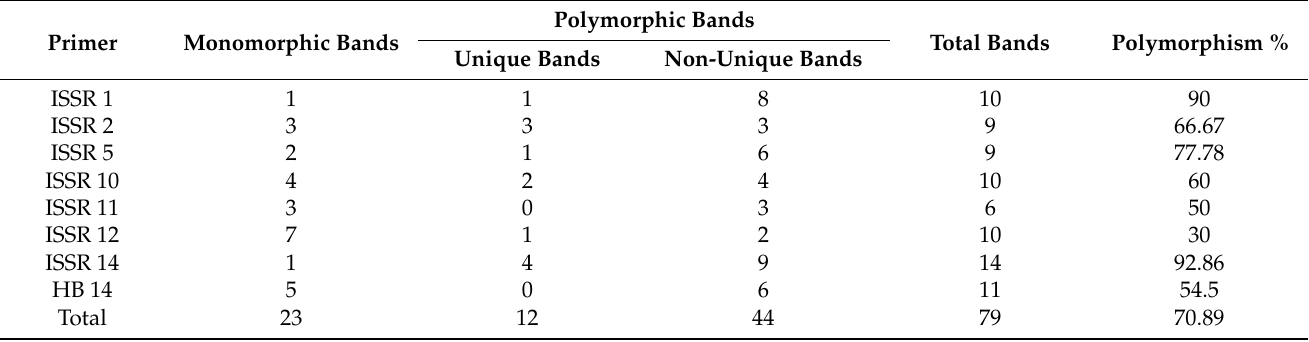
Table 4. Total number of the amplified DNA bands, their type and the percentage of the total polymorphism resulted from eight ISSR primers in the treated V. faba seeds with 3% C. acutum latex and different concentrations of its silver